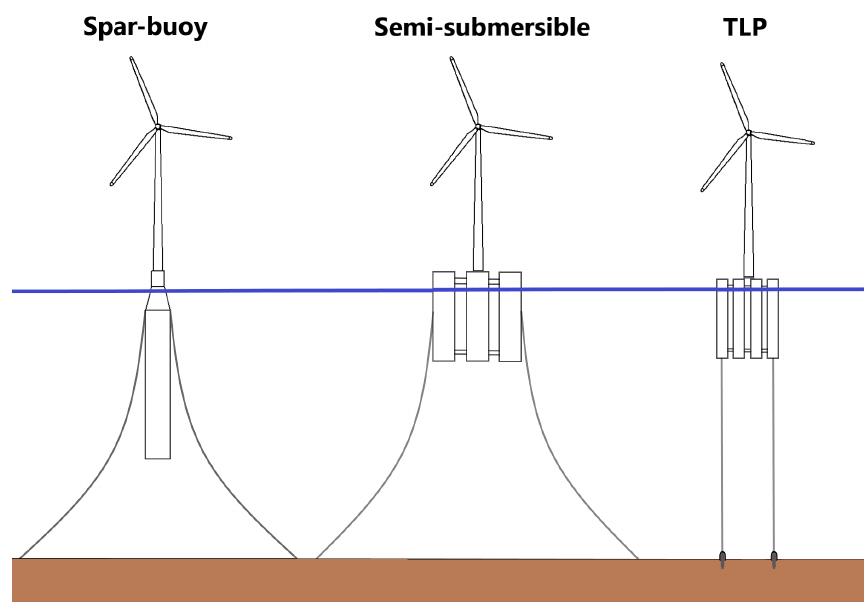
Figure 4. Floating offshore wind farm foundations with according stabilization